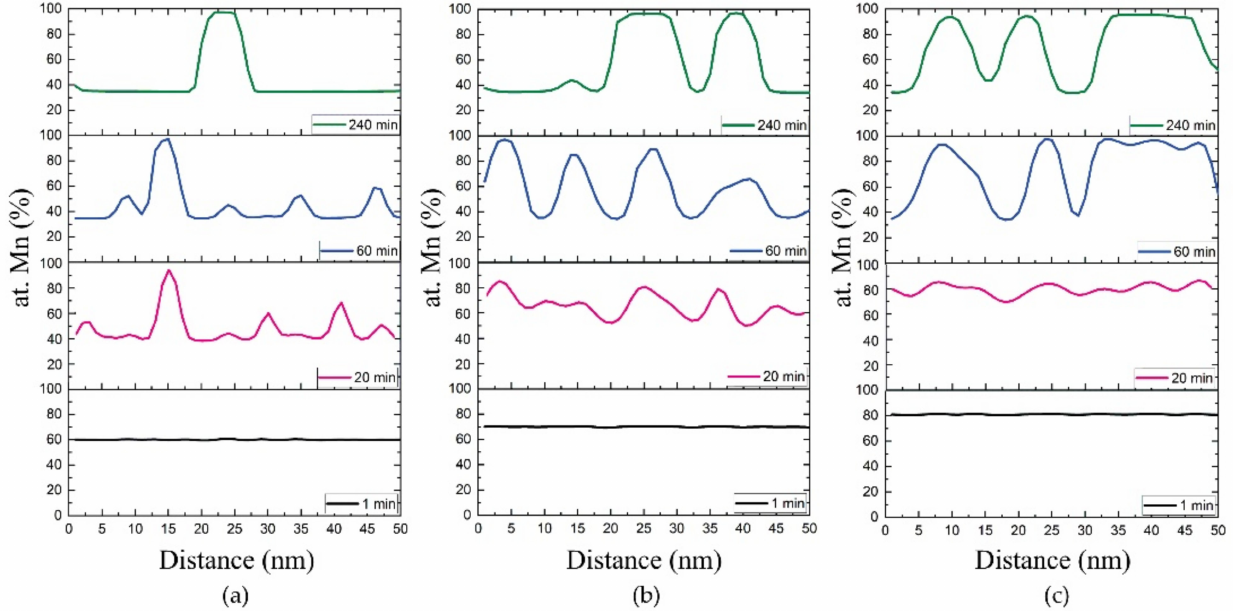
Figure 4. Calculated concentration profiles of ( a ) Mn-40 at. %Cu, ( b ) Mn-30 at. %Cu, and ( c ) Mn-20 at.%Cu alloys aged at 400 ◦ C for different